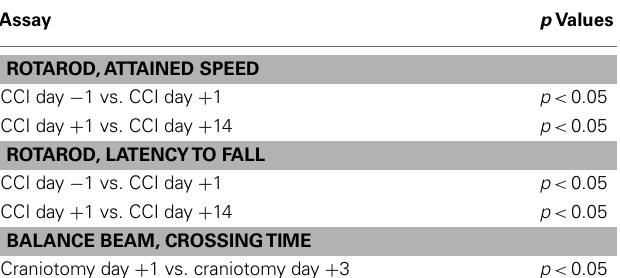
Table 2 | Statistically significant behavior